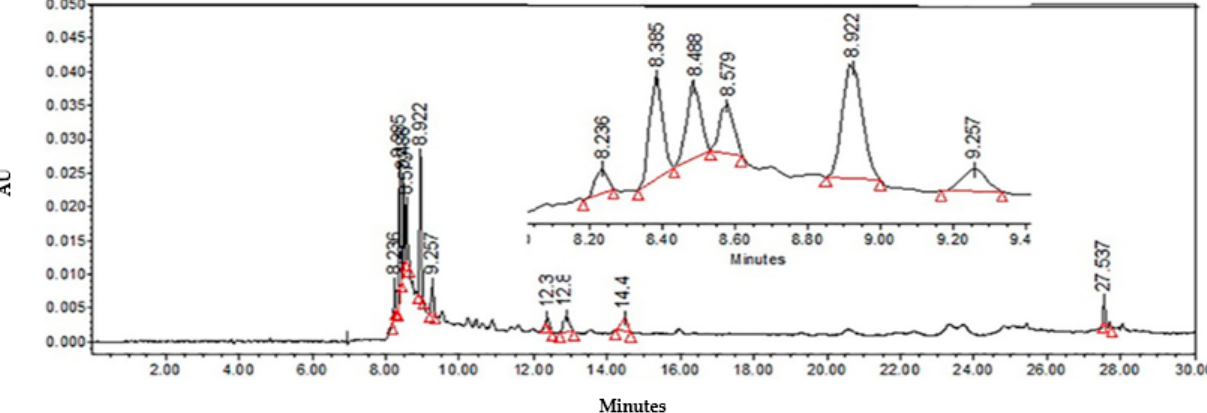
Figure 1. HPLC chromatogram at 350 nm of Larrea tridentata hydroalcoholic extract. Antibacterial activities of these compounds were previously reported. De Souza et al. (2005) reported that coumarin and 45 coumarin derivatives are active against Gram- positive and Gram-negative bacteria. Similarly, De la Cruz-Sánchez et al. (2019) reported that Morinda citrifolia antibacterial activity was associated with coumarin, identified as scopoletin